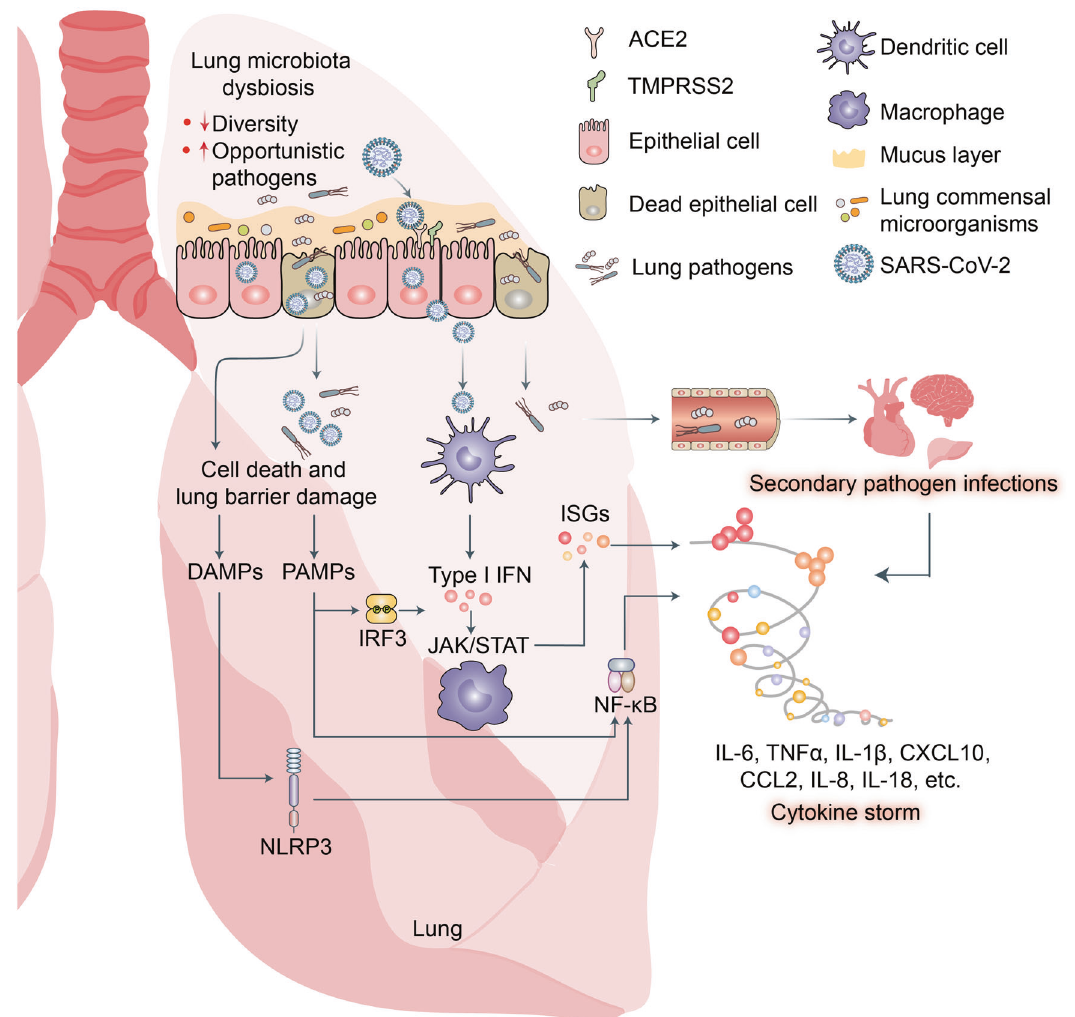
Fig. 3 Potential mechanisms of cytokine storm and secondary pathogen infections resulting from lung microbiota dysbiosis in patients with COVID-19. SARS-CoV-2 infection disrupts lung microbiota eubiosis. Increased abundance of opportunistic pathogens may intensify lung cytokine storm and cause secondary pathogen infections in patients with COVID-19. Pathogen-associated molecular patterns (PAMPs) released from invading opportunistic pathogens may be recognized by host innate lymphocytes such as macrophages and dendritic cells (DCs) via pattern recognition receptors (PRR) including Toll-like receptors (TLRs), RIG-I-like receptors (RLRs), and NOD-like receptors (NLRs). These induce expression of proin fl ammatory factors via NF- κ B signaling, interferons via IRF3 signaling, and numerous interferon-stimulated genes (ISGs) via JAK/STAT signaling. Excess cytokines may exacerbate COVID-19 cells. 132 B 0 AT1 substrates such as tryptophan and glutamine activate the release of antimicrobial peptides, promote TJ formation, downregulate lymphoid proin fl ammatory cyto- kines, and modulate mucosal cell autophagy via mTOR signaling. 133,134 As ACE2 is a molecular B 0 AT1 chaperone, both molecules may be co-internalized during SARS-CoV-2 infection and the net amount of B 0 AT1 on the cell membrane surface may decrease. A recent study corrobo- rated this hypothesis. 135 Cryoelectron microscopy was used to examine the ultrastructures of the ACE2-B 0 AT1 complex as well as another one involving the SARS-CoV-2 receptor- binding domain (RBD). The analysis disclosed that the ACE2- B 0 AT1 complex exists as a heterodimer and the SARS-CoV-2 spike protein (S1) may interact with it. 135 SARS-CoV-2- induced B 0 AT1 downregulation on the luminal surfaces of intestinal epithelial cells might contribute to microbiota dysbiosis which, in turn, promotes pathogen invasion and ultimately facilitates cytokine storms and COVID-19 exacerbation. 134